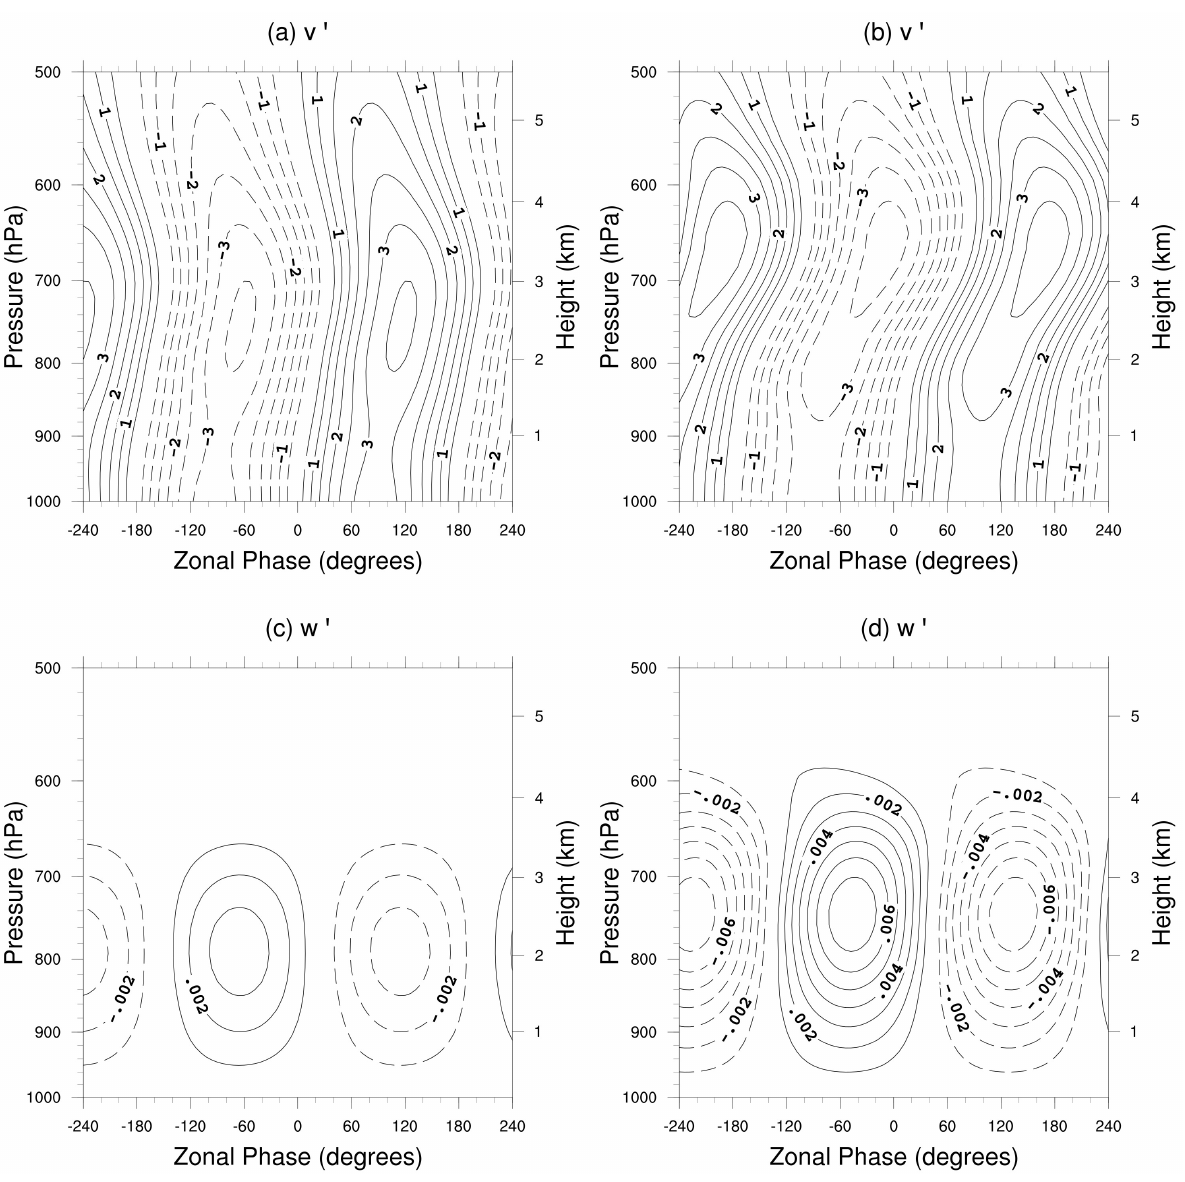
Figure 3. ( a , b ) The meridional velocity, v (cid:48) , and ( c , d ) vertical velocity, w (cid:48) , fields at 18 ◦ N for the passive (left column) and active (right column) experiments. Solid (dashed) contours correspond to positive (negative) values. Contour intervals are 0.5 m s − 1 for v (cid:48) and 0.001 m s − 1 for w (cid:48)